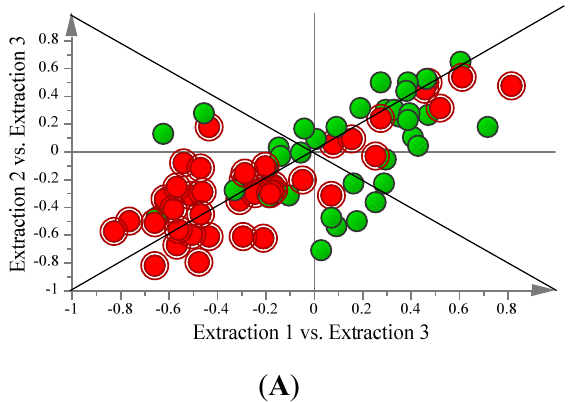
Figure 3. Shared and unique structure (SUS) plots of fatty acid and polar metabolites from S. cerevisiae by one of three chloroform/methanol/water based extraction protocols. Extraction 1 and Extraction 2 are plotted against Extraction 3 in order to observe the shared and unique metabolites obtained with Extractions 1 and 2. Red metabolites are those with a VIP greater than 1 as identified by OPLS-DA modelling. ( A ) SUS plot of polar metabolites. ( B ) SUS plots of FAME